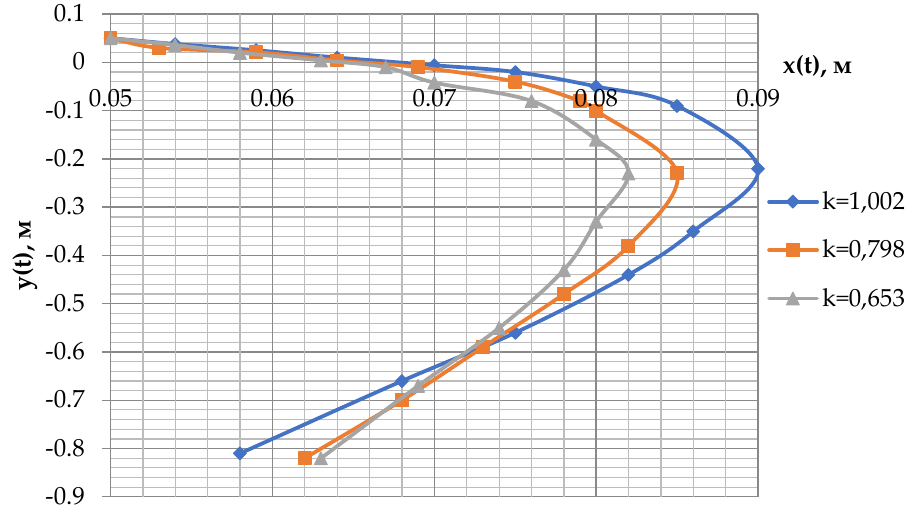
Figure 5. Dependence of particle motion at a rotation frequency of n = 3000 min − 1 .